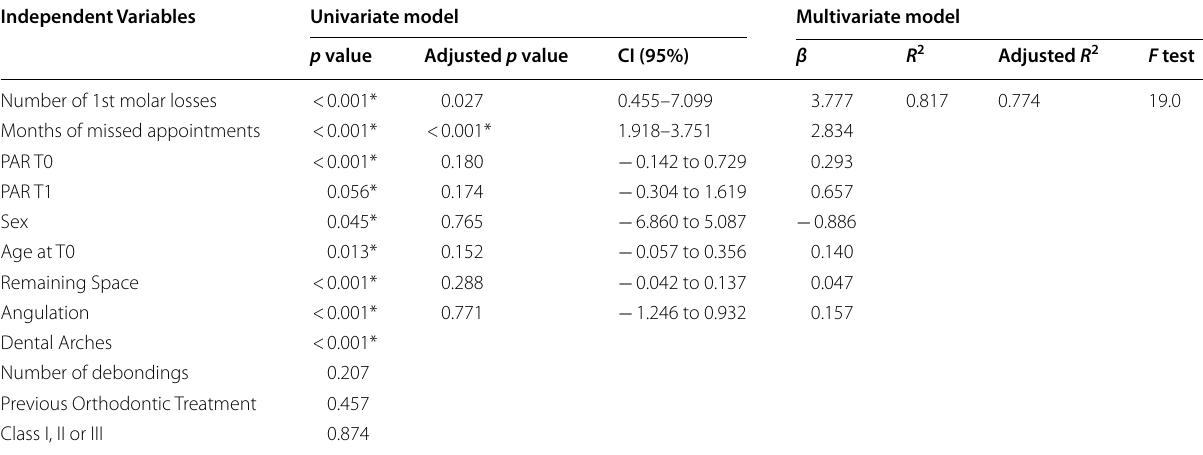
CI, Confidence Interval * Statistically significant at p <